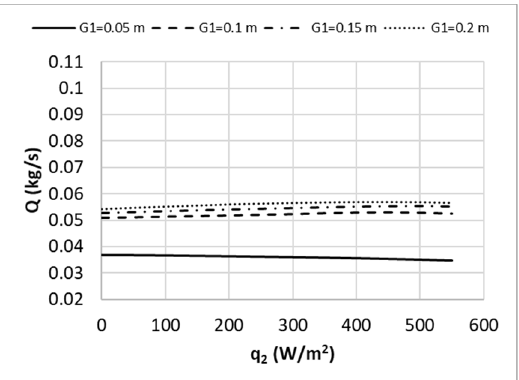
Figure 5. Mass flow rate of Configuration (I) ( G 2 = 0.1 m) at different values of q 2 and G 1 .